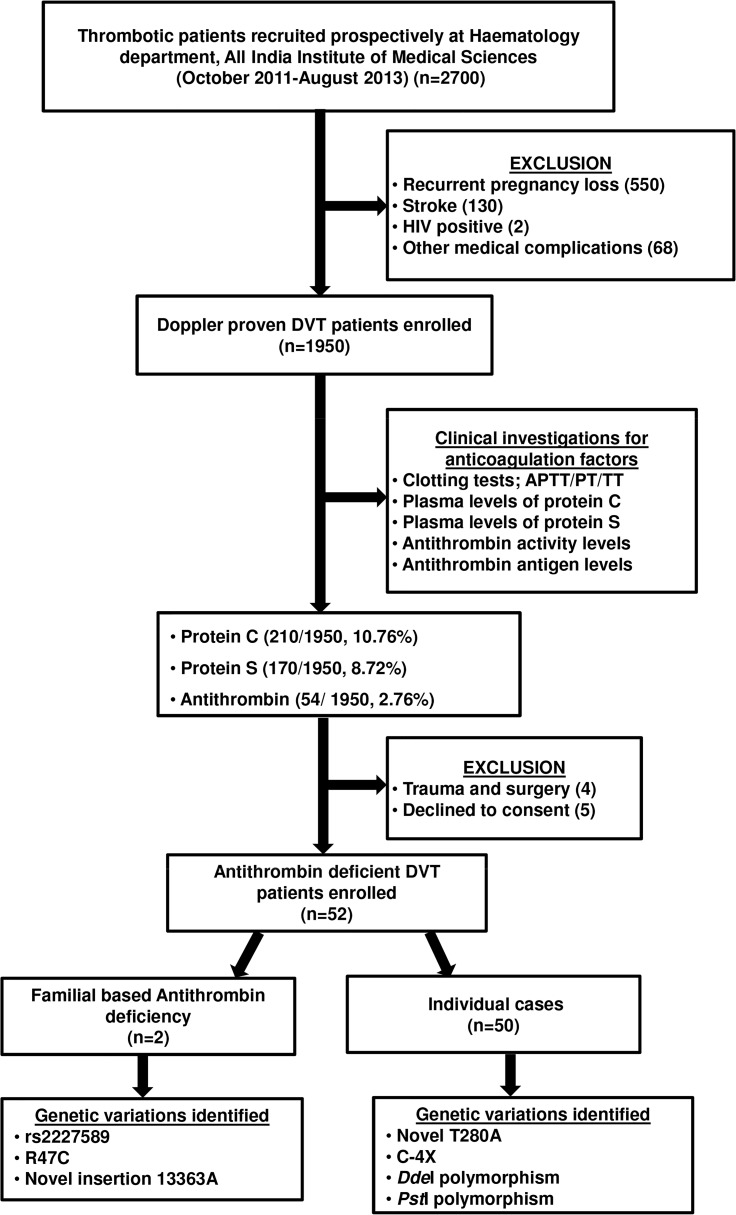
Flow chart summarizing the patients recruited, techniques employed and results of the study.